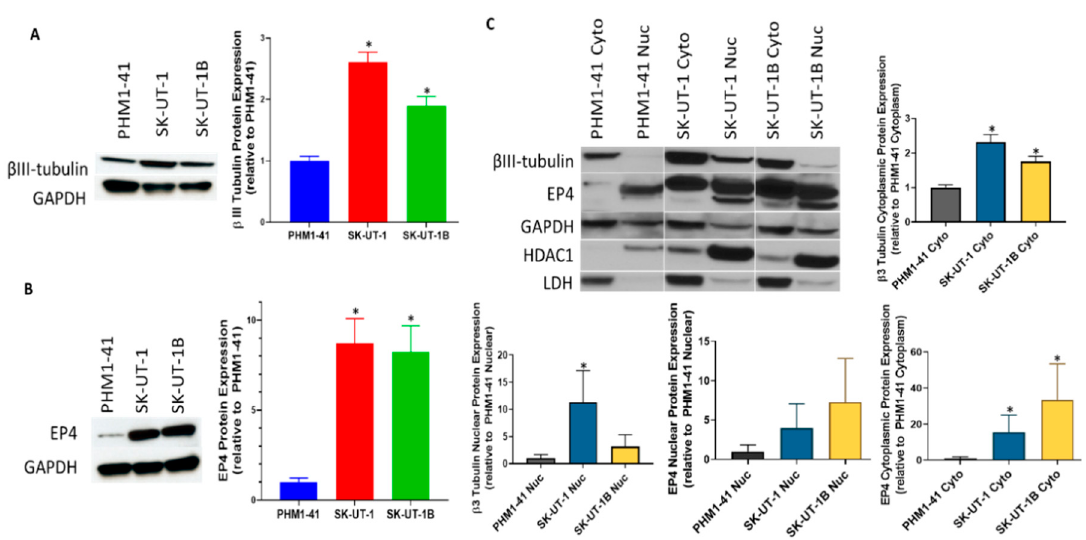
Figure 4. Protein expression in cell lines. ( A ) Class III β -tubulin and ( B ) EP4 protein expression were analyzed via Western blot in sarcoma (SK-UT-1) and carcinoma (SK-UT-1B) cell lines relative to normal immortalized uterine myometrial cell line PHM1-41. Both class III β -tubulin and EP4 were found to be overexpressed compared to PHM1-41. The bar graphs on the left indicate densitometry measurement of the Western blots. Protein expression analysis of the nuclear and cytoplasmic fractions is shown in ( C ). The bar graphs below on the right indicate densitometric measurement of cytoplasmic and nuclear class III β -tubulin or EP4 proteins normalized to GAPDH. Both class III β -tubulin and EP4 proteins in the cytoplasmic fractions of SK-UT-1 and SK-UT-1B had significantly more expression compared to PHM1-41. Only class III β -tubulin in the nuclear fraction of SK-UT-1 had significantly increased expression compared to PHM1-41. The following antibodies were used as loading controls: GAPDH (total protein), histone deacetylase 1 (HDAC1) (nuclear loading control), and lactate dehydrogenase (LDH) (cytoplasmic loading control). * p < 0.01.